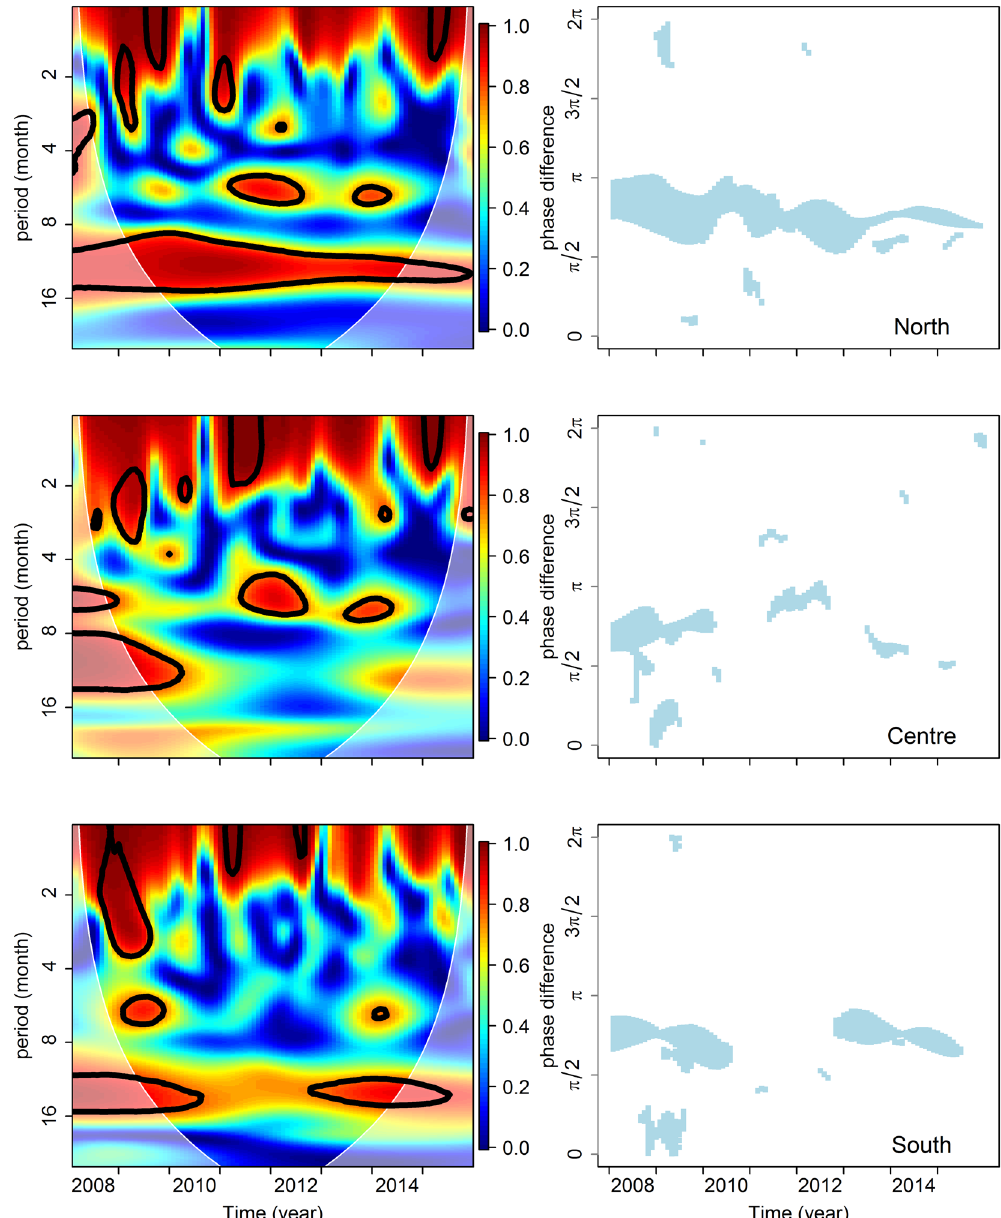
Figure 2. Wavelet coherence analysis between time series of reported AIOs and average absolute humidity in the three identified climatic regions of Vietnam (above: North, middle: Centre, below: South). Results of wavelet coherence analysis for the other climate variables are displayed in Supplementary Fig. S1. Left: Wavelet coherence indicated by a colour spectrum (blue: weak coherence, red: high coherence) as a function of the month of study period (x-axis) and the wavelet period (i.e. inverse frequency of wavelet oscillations) (y-axis). Black lines delineate areas of significant coherence between wavelet transforms (with an alpha risk ≤ 5%). White lines delineate the cone of influence, i.e. the area where computed coherences are strongly influenced by edge effects. Right: identified phase shifts from wavelet transforms of AI incidence to wavelet transforms of absolute humidity, when the two are significantly